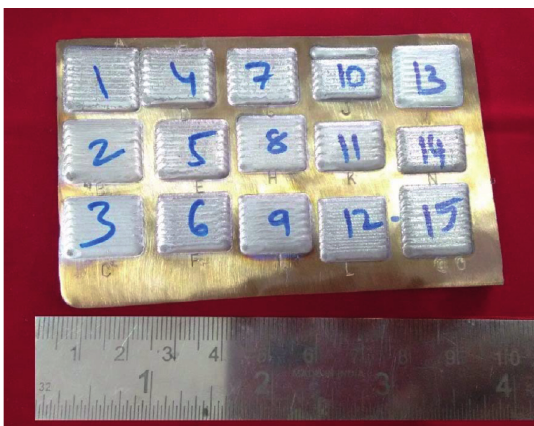
Figure 2: Fabricated